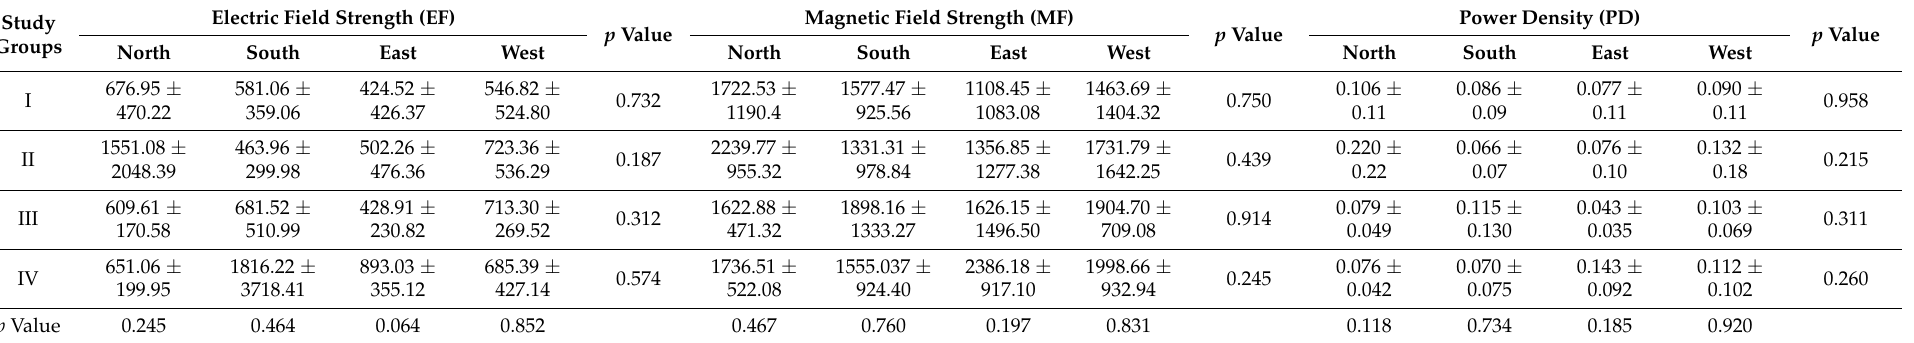
Table 3. Inter- and intragroup comparative analysis of Electric field strength, magnetic field strength and power density among the study group at different